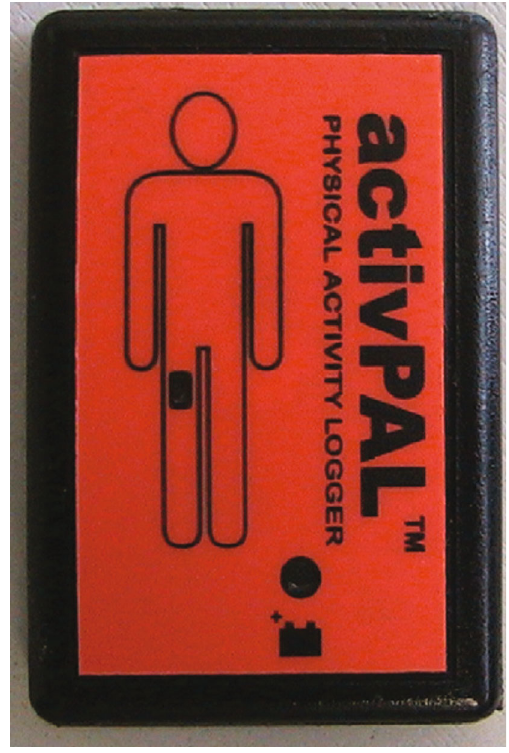
Figure 1: ActivPAL 3